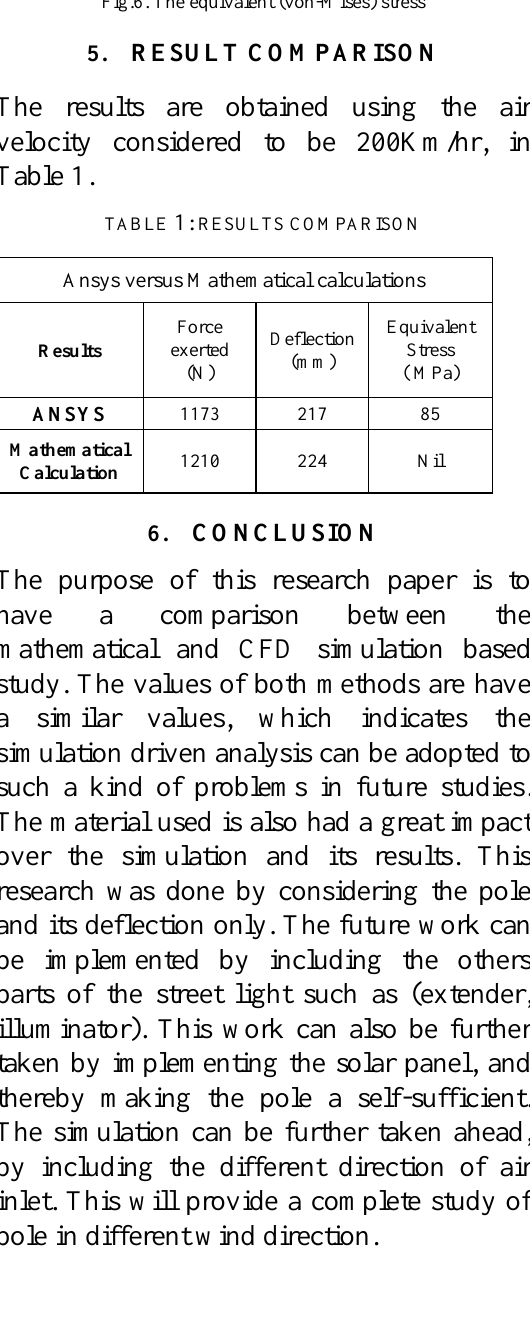
Fig.6. The equivalent (von-Mises)